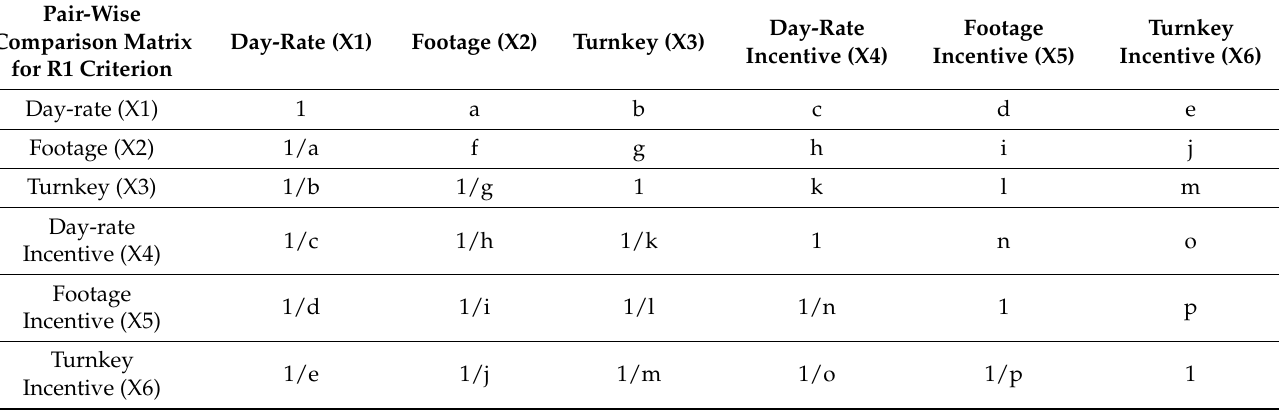
Table 8. Pair-wise comparison matrix for six